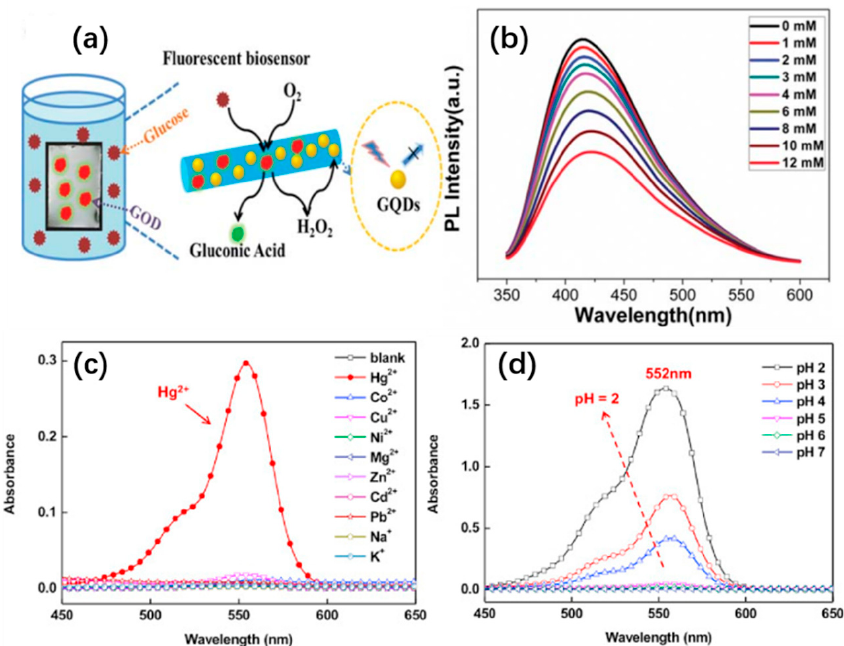
Figure 7. Fabrication of NP interfaces for fluorescent sensors: Fluorescent detection of glucose ( a ) the possible detection mechanism and ( b ) the fluorescence spectra of the PVA / graphene quantum (PVA / GQD) nanofibrous membrane in the presence of GQD and glucose of various concentrations [115], copyright 2014 American Chemical Society; ( c ) absorption spectra of (c) RhBN 2 AM (7 × 10 − 3 M in CH 3 OH) at various pH values and ( d ) RhBN 2 AM (2 × 10 − 5 M in CH 3 CN) in an aqueous solution (Hg 2 + ,Co 2 + ,Cu 2 + , Ni 2 + ,Mg 2 + ,Zn 2 + e 2 + ,Pb 2 + ,Na + , and K + ;10 − 4 M Tris-HCl bu ff er at pH 7), respectively [117], copyright 2017 Elsevier Ltd.